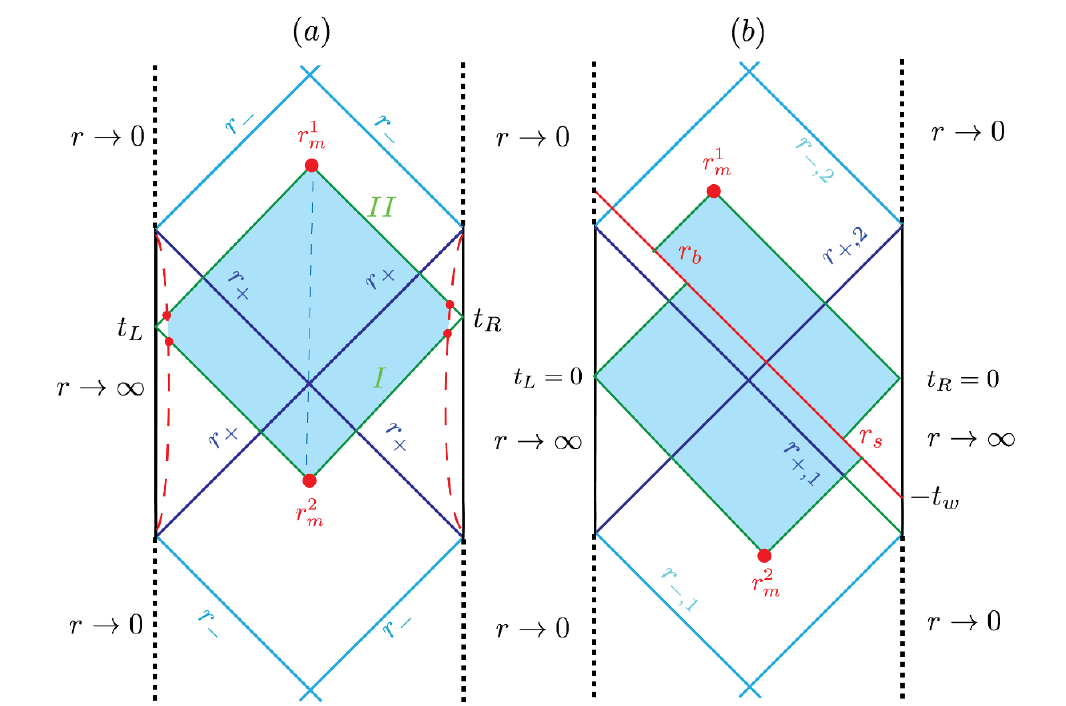
Figure 1 . (a) Penrose diagram for the Reissner-Nordstrom-AdS black hole (2.7). The nonextremal black holes have an outer event horizon at r = r + and an inner Cauchy horizon r = r (cid:0) . The shaded blue region corresponds to a typical WDW patch anchored to symmetric boundary time slices with t L = t R = t= 2. (b) Penrose-like diagram of an Reissner-Nordstrom-AdS black hole with a shock wave inserted on the right boundary at the boundary time t R = (cid:0) t w | see eq. (2.37). In order to not tilt the asymptotic boundary after the shock wave, we adopt the Dray-t’Hooft prescription that the null geodesics crossing the collapsing shock wave